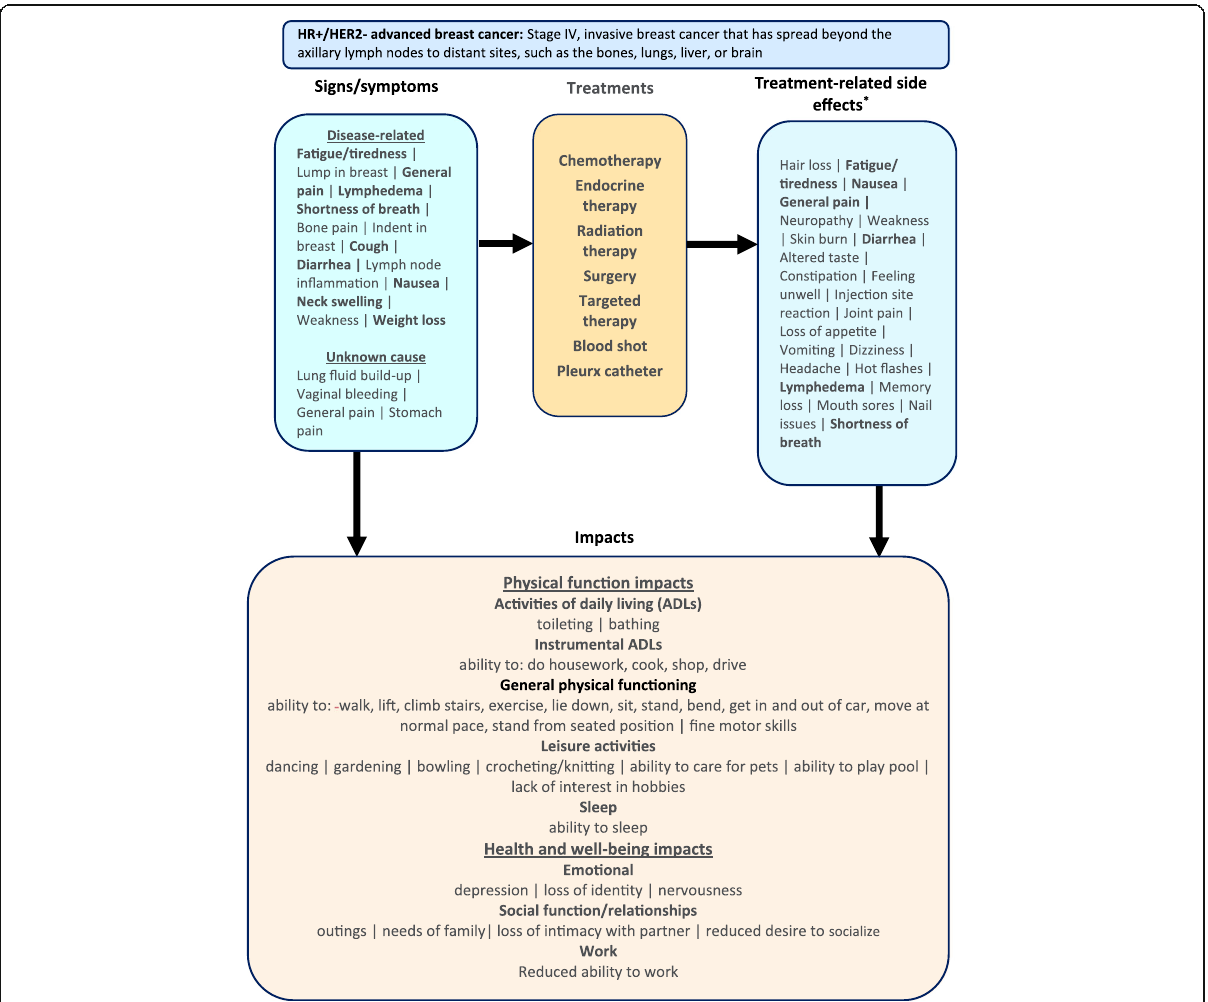
Fig. 1 Patient-centric conceptual model of HR+/HER2- advanced breast cancer. Concepts that are shown in bold were reported by subjects patients to be related to both the disease and its treatment. Disease-related, treatment-related, and unknown cause concepts are ordered by frequency with which subjects patients reported concept attribution.*The following treatment-related side effects were reported by one subject patient each: acid reflux, allergic reaction, bleeding, bloating, breast size decrease, chemotherapy brain, cough, flu-like symptoms, flushing, gout, itching, lack of balance, neck swelling, runny nose, skin peeling, sore throat, stiffness, stomach pain, weight gain, weight